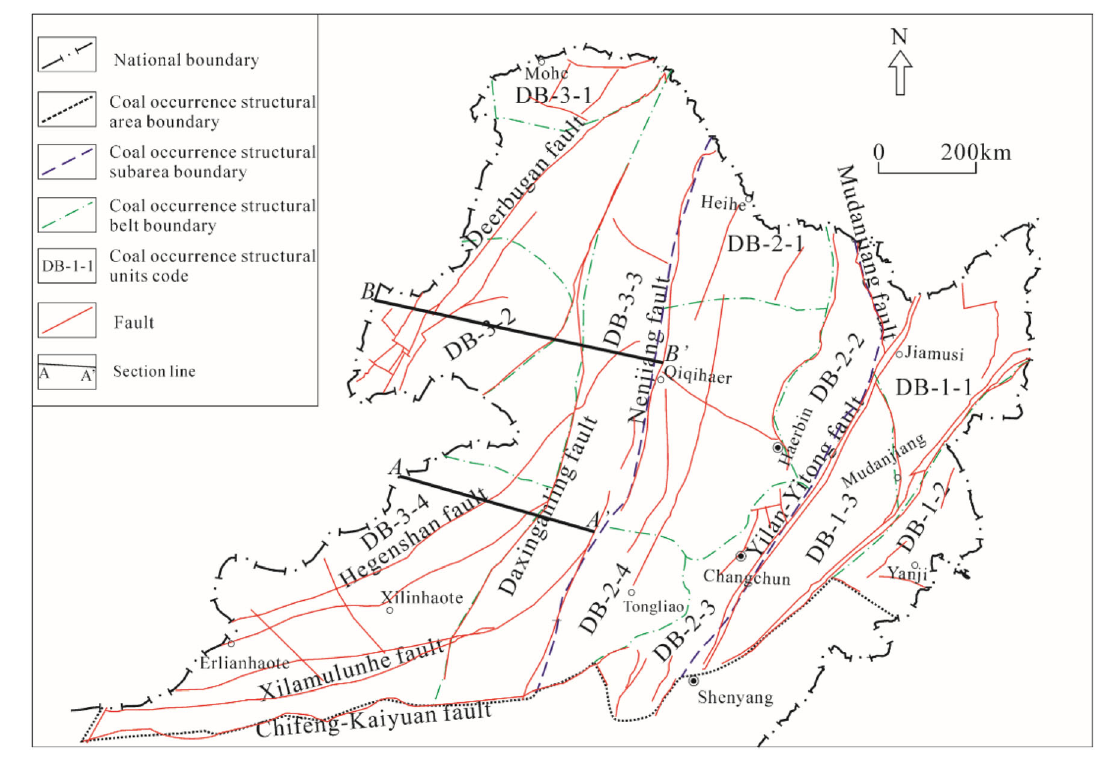
Fig. 3 Diagram of the structural outline of the Northeast China coal occurrence structural area